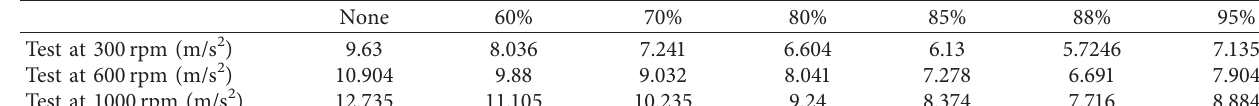
Table 4: Root mean square value of acceleration.